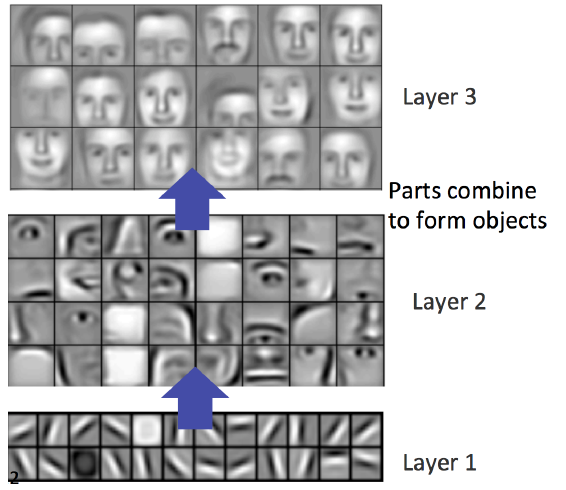
Figure 1. The lower level features progressively combine to form higher layer features in deep